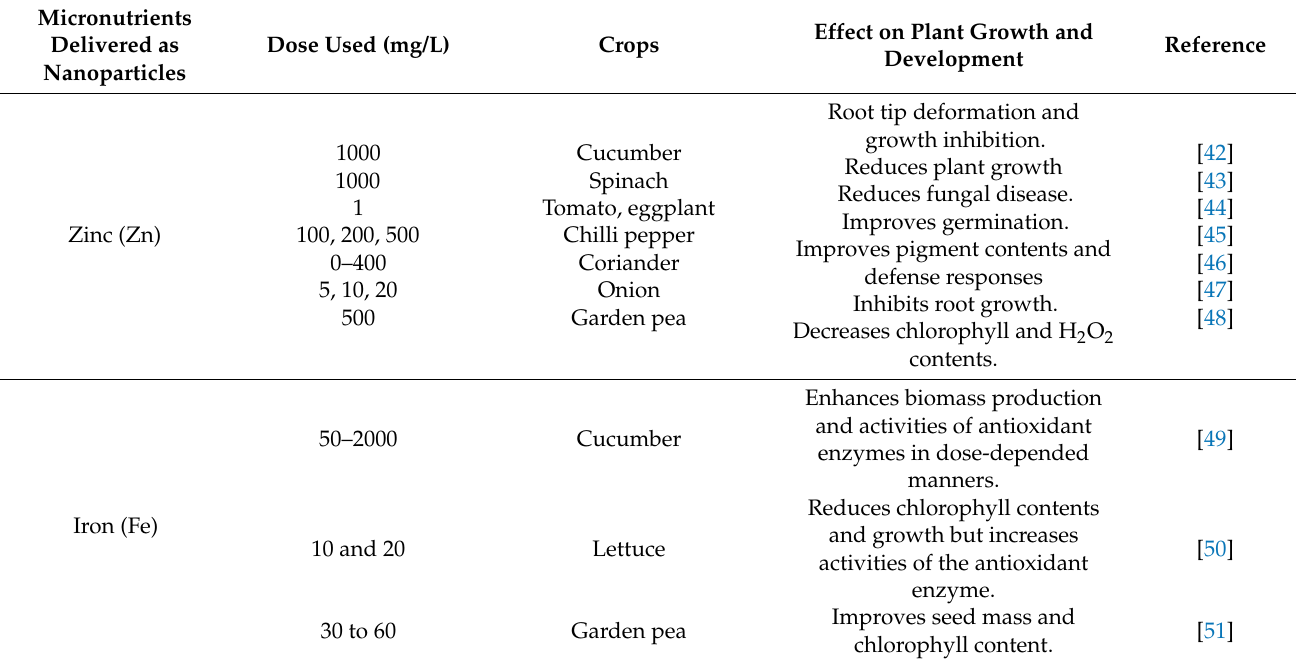
Table 1. Impact of different micronutrient nano-fertilizers on various horticultural crops.